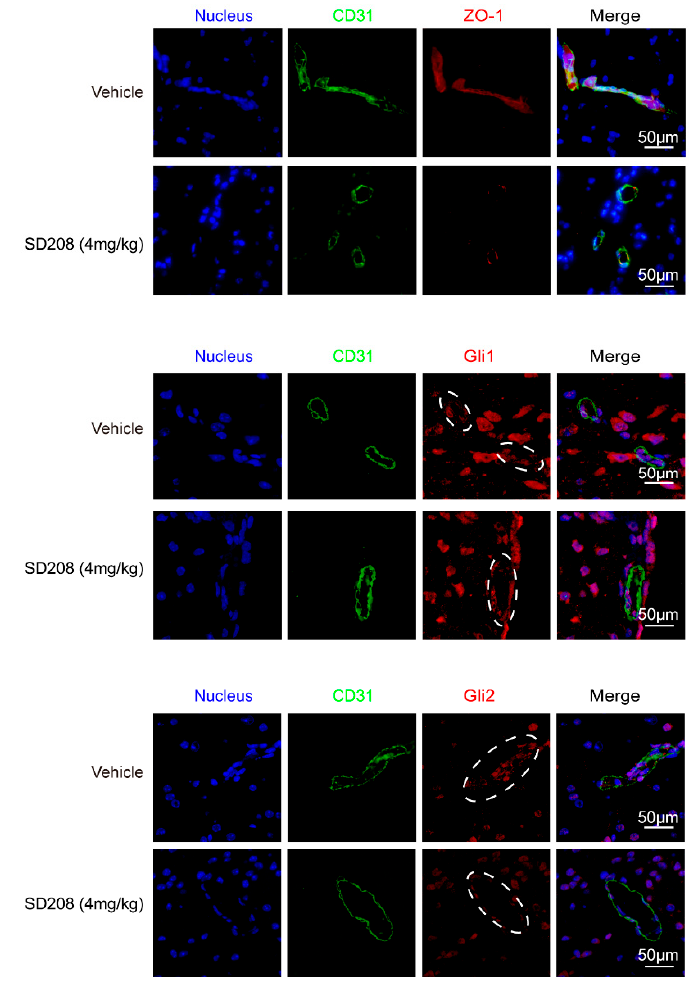
Figure 3. SD208 treatment decreased ZO-1 and Gli2 expression in mice BMECs. Mice were treated with SD208 at 4 mg/kg, and the expression of ZO-1, Gli1, and Gli2 was detected by IF. BMECs are marked in green (with CD31). Scale bars indicate 50 μ m. The rings of doted lines indicate Gli1 or Gli2 expression in BMECs.